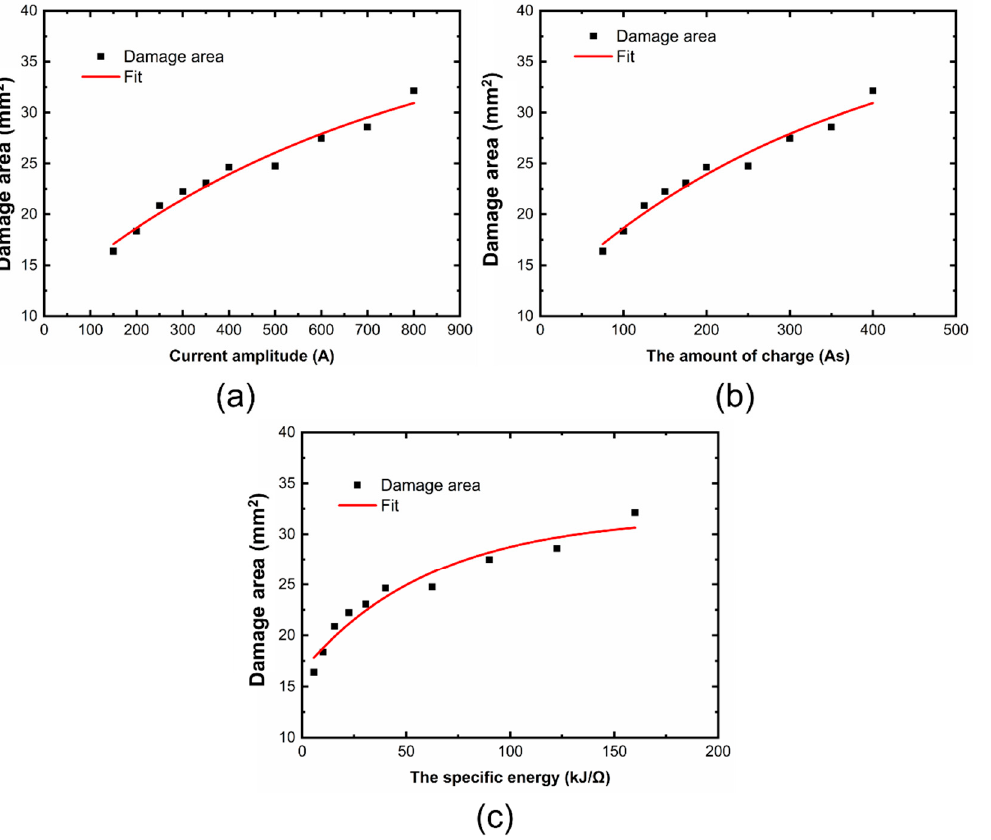
Figure 23. The relationship between penetration damage area and current parameters, ( a ) damage area versus current amplitude curve, ( b ) damage area versus charge amount curve, ( c ) damage area versus specific energy curve.